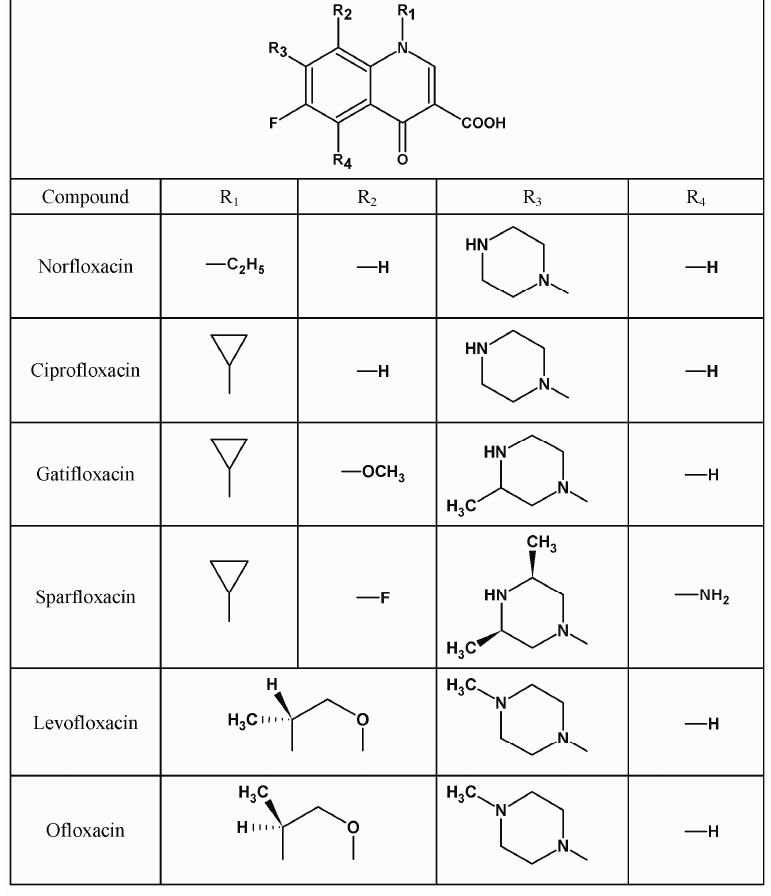
Figure 1 . Component structure of some members of fluorquinolone antibiotic